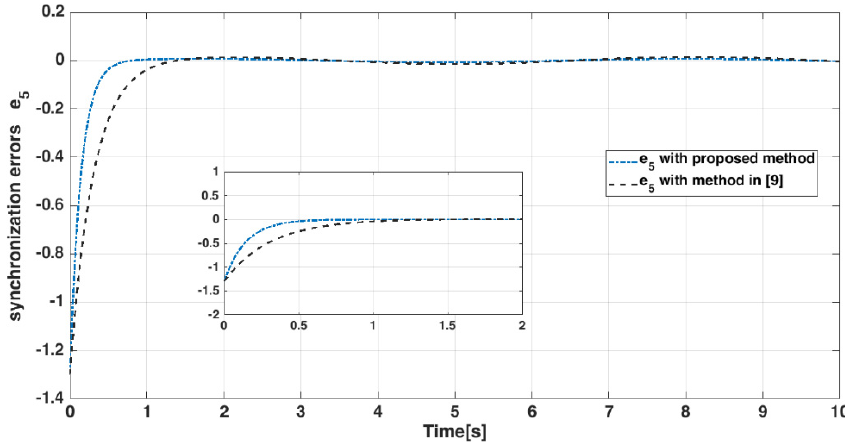
Figure 18. State error 𝒆 𝟓 of master-slave systems.